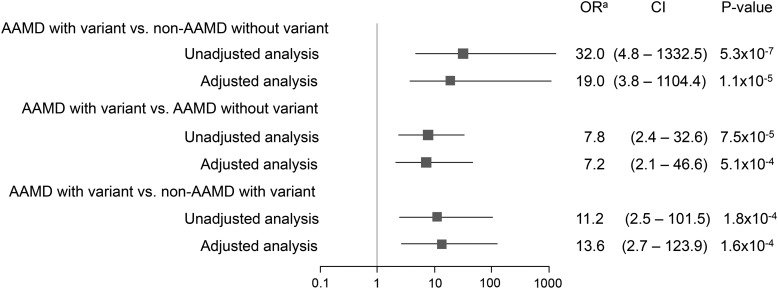
The association between groups defined by advanced age-related macular degeneration (AAMD)/CFI rare variant status and low serum FI level. Unadjusted analyses: estimated odds ratio of the association between AAMD/CFI rare variant status and low serum FI (≤29.3 µg/ml). Adjusted analyses: estimated odds ratio of the association between AAMD/CFI rare variant status and low serum FI (≤29.3 µg/ml) after adjusting for age at the time of blood sample (≤80, >80 yr), gender, body mass index (<25, ≥25) and smoking status (never, ever). All analyses used using exact binomial probabilities based on the exact option of PROC FREQ in SAS 9.3. OR: odds ratio; CI: confidence interval. aOR > 1 indicates that low serum FI increases risk, while OR < 1 indicates that low serum FI is protective.